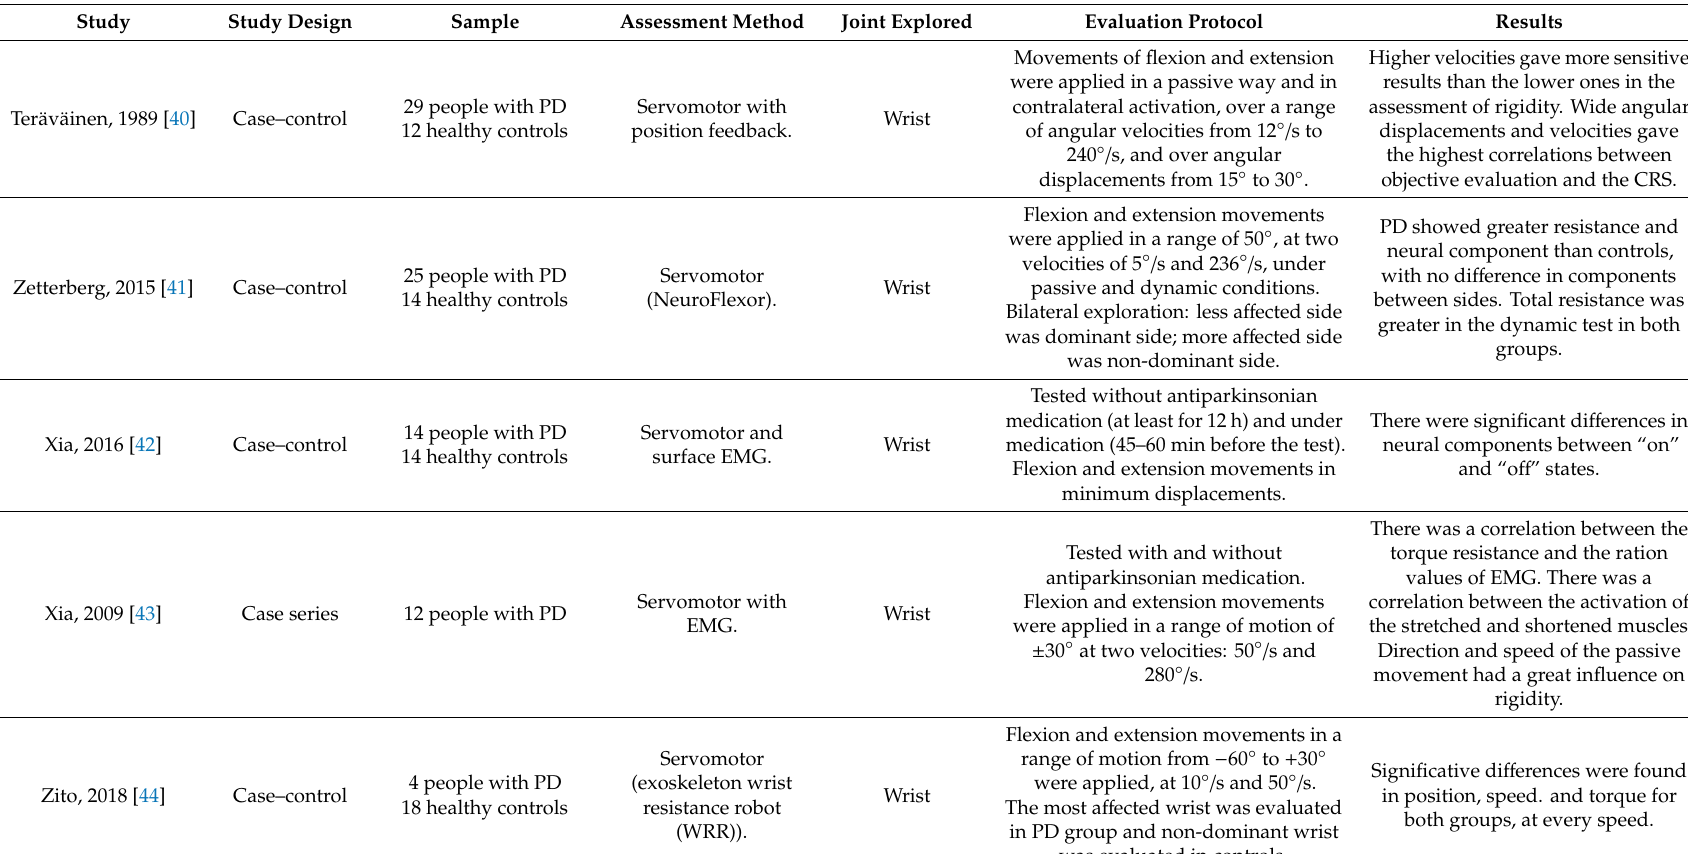
Table 4. Electro-mechanized methods attached to the body for joint mobilization